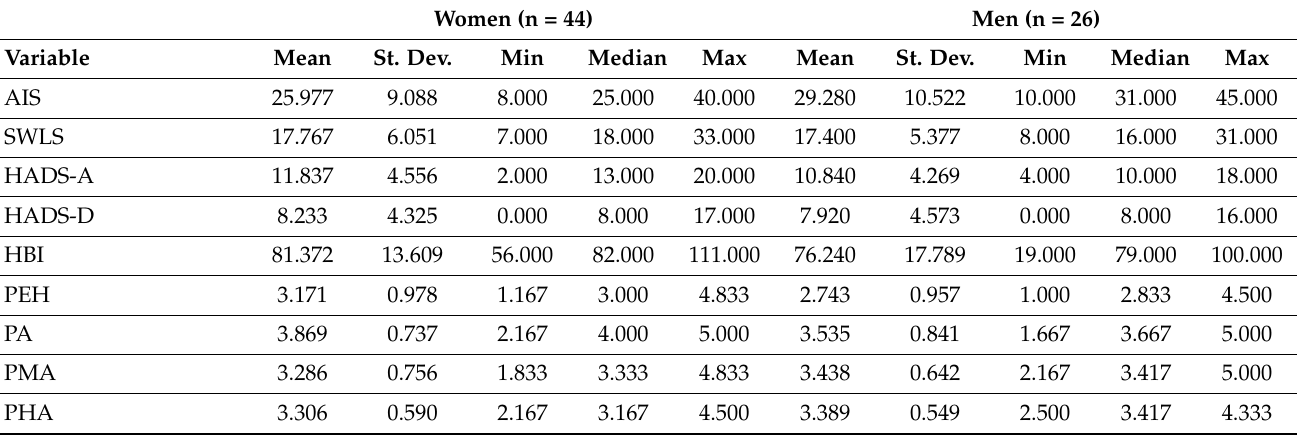
Table 3. Gender differences in the studied